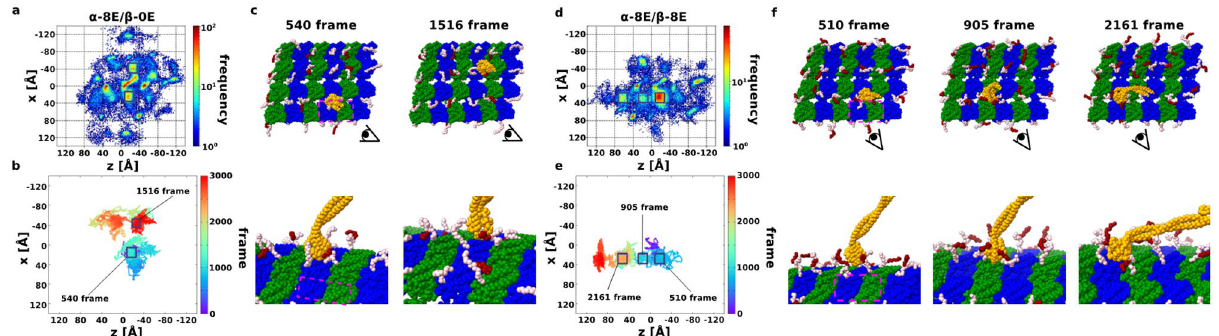
Figure 3. Low-affinity state dynein with short poly-E MT. ( a , d ) Heat map of the position of the low-affinity state MTBD on the poly-E MT, with 20 trajectories overlaid. The coloring method is same with Fig. 1d. ( a ) is α-tubulin have 8 length poly-E, and β-tubulin does not have poly-E (simply denoted α-8E/β-0E). ( d ) is both α- and β-tubulin have 8 length poly-E (α-8E/β-8E). ( b , e ) Representative trajectory of MTBD on the poly-E MT. The coloring method is same with Fig. 1b. ( b ) is the representative one in the case α-8E/β-0E, and ( e ) is the representative one in the case α-8E/β-8E. ( c , f ) Snapshots picked up from Fig. 3b, e inboxes. The coloring method of dynein and tubulins are same with Fig. 1e, and poly-E colored